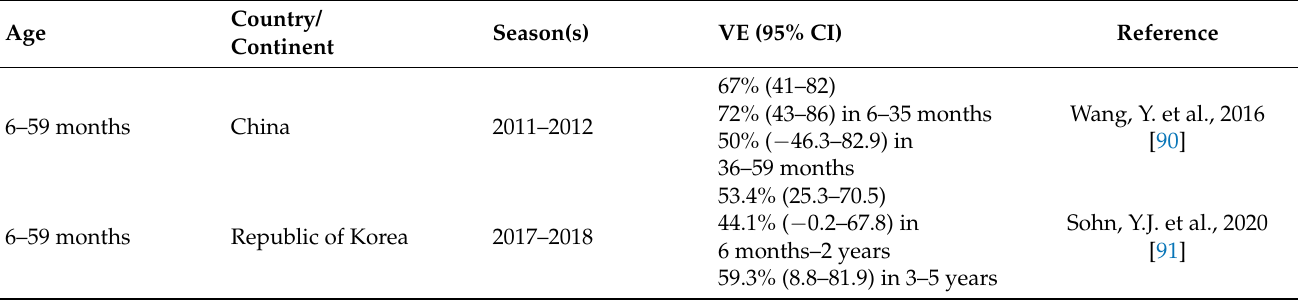
Table 2. Overview of studies on VE conducted in